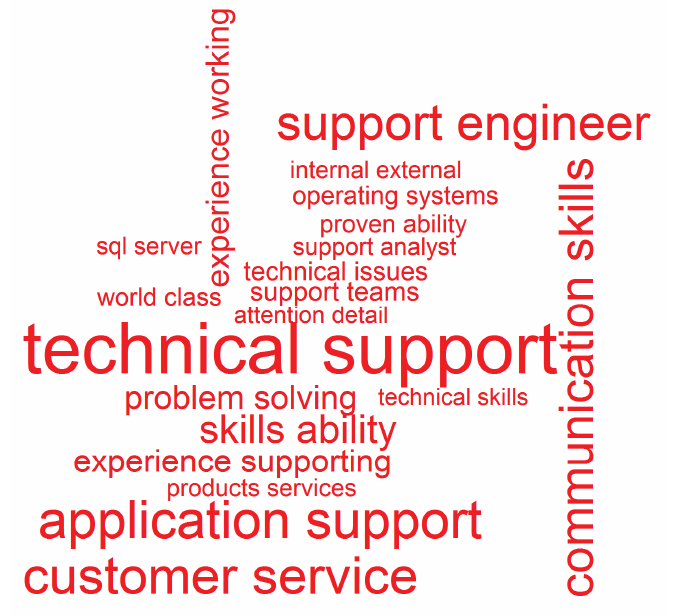
Figure 18. Job Descriptions Visualization—Support (unseen